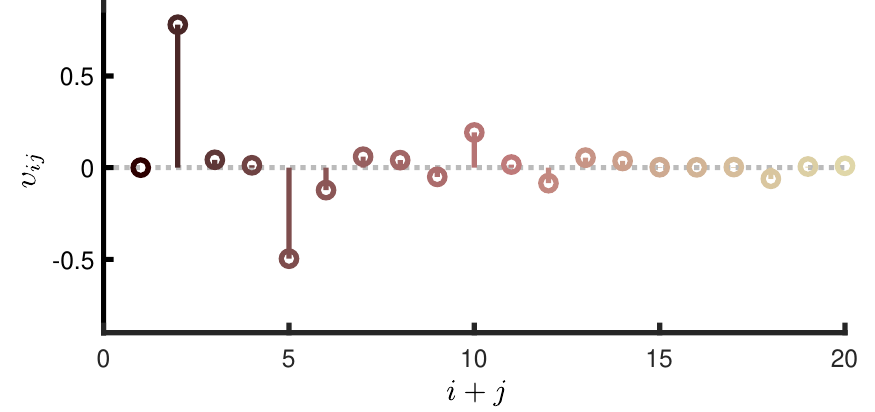
Figure 6. Computed coefficients ε ij for the polynomial expansion